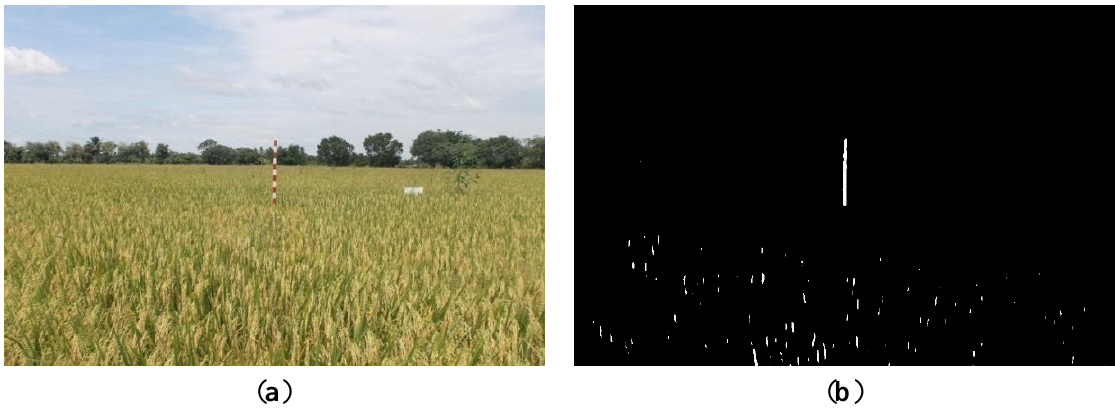
Figure 21. Comparison between ( a ) RGB and ( b ) resultant binary images using proposed method with excess green feature on 12 August